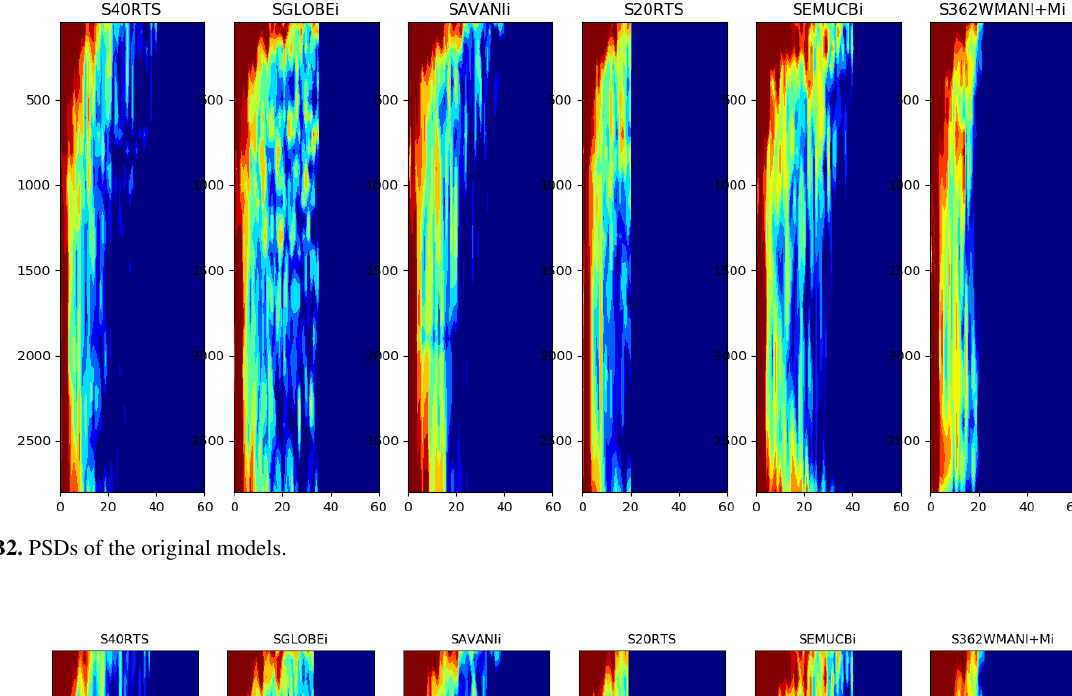
Figure B2. PSDs of the original models.